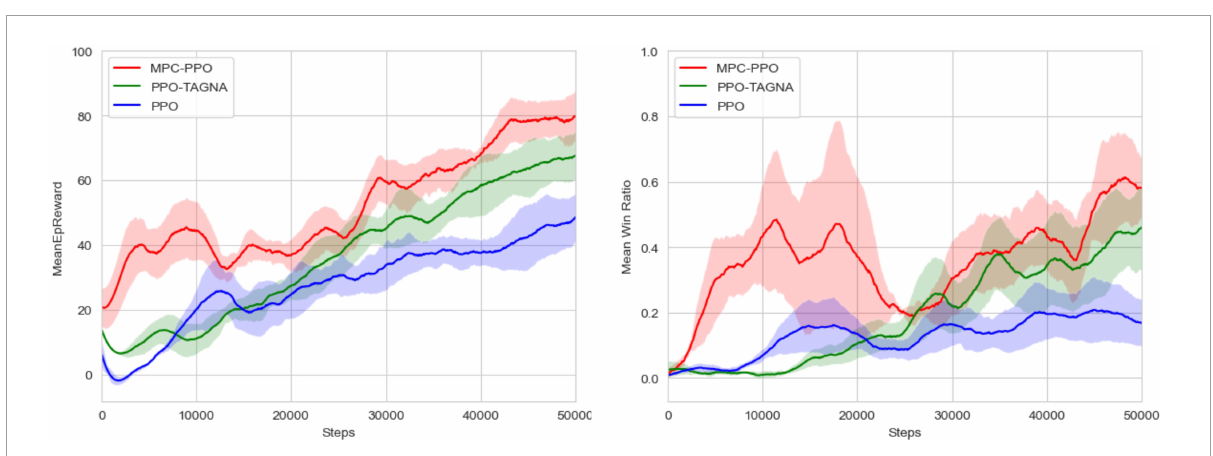
FIGURE6 Comparison of agent architecture training effect.